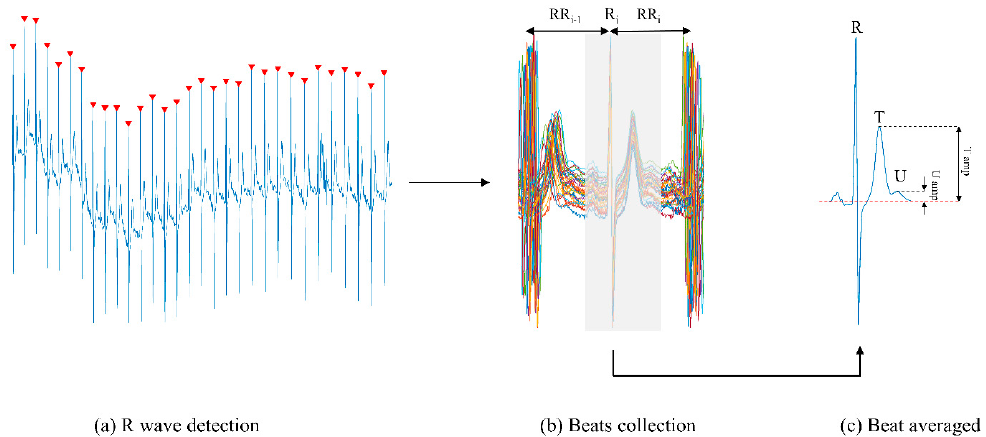
Figure 2. Electrocardiogram (ECG) signal processing stages to recover the U wave illustrated in a post-exercise recording. ( a ) R wave peaks ( ▼ ) were detected in the ECG lead. ( b ) Qualifying beats were collected and aligned to their R peak (R i ). Beats with RR i < 500 ms were excluded to avoid U wave contamination from following P waves. An averaged beat was calculated by averaging the collected beats in a window comprising the P wave, QRS complex, T wave and U wave (represented by the grey shaded area). ( c ) The U wave is readily observable in the average beat and the amplitude of the U wave (U amp) was measured from the stable baseline (red dashed line) to the peak of the U wave. T wave amplitude (T amp) was also measured.